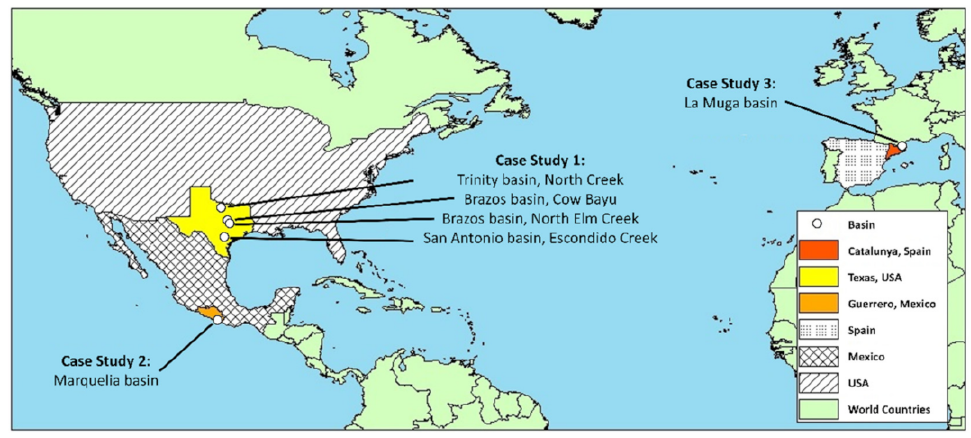
Figure 1. Location of the three case studies and the analysed basins: four in USA (Case Study 1), one in Mexico (Case Study 2), and one in Spain (Case Study